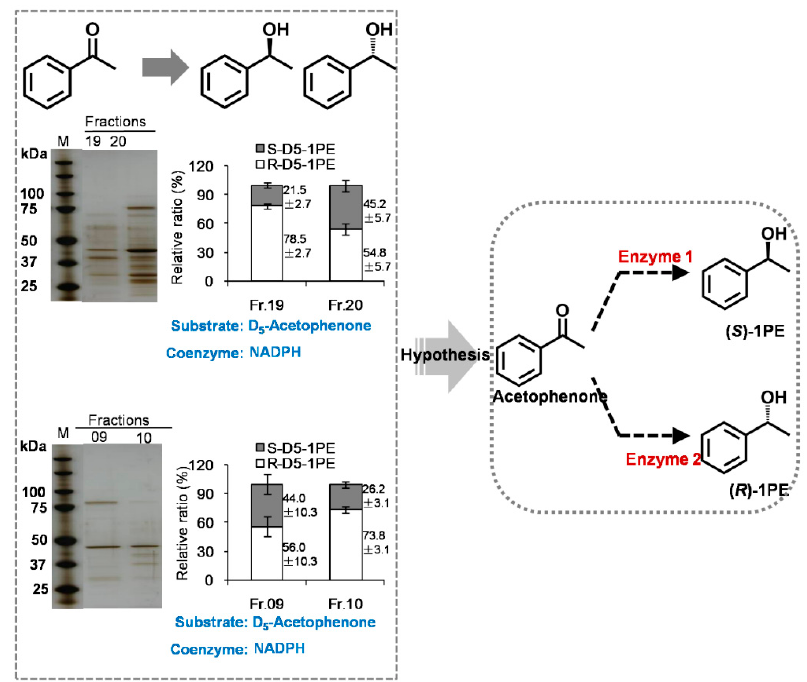
Figure 2. Hypothesis of enzymes involved in the pathways leading from acetophenone to ( R )-1PE or ( S )-1PE. The fractions 19 and 20 were from the 2nd purification-HiTrap Phenyl FF(HS) column (See Figure 1). The fractions 09 and 10 were from the 3rd purification-Resource Q column (See Figure 1). Data are expressed as Mean ± S.D. ( n =